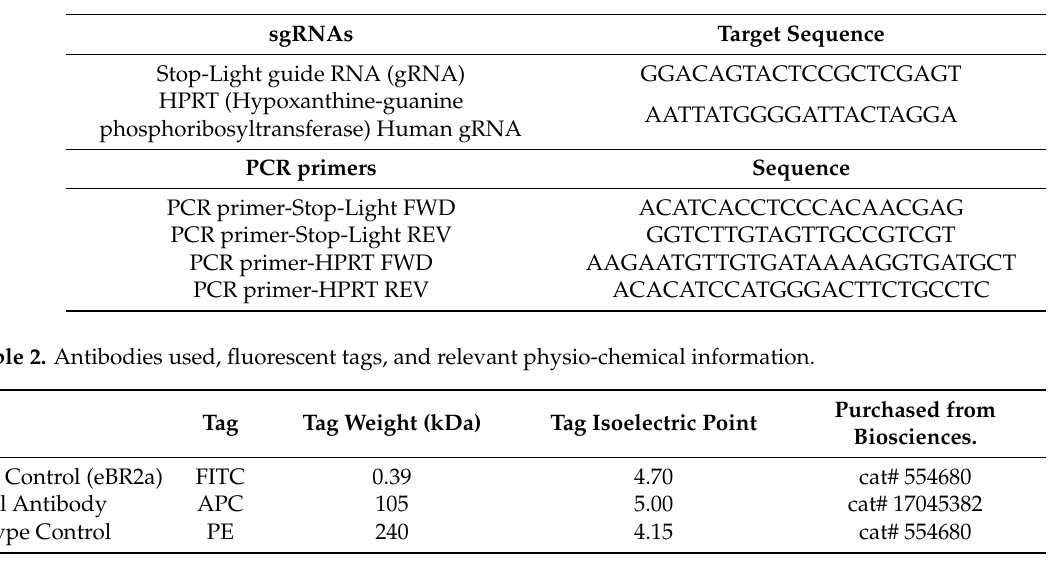
Table 1. Oligonucleotides used and their sequences. sgRNAs Target Sequence Stop-Light guide RNA (gRNA)